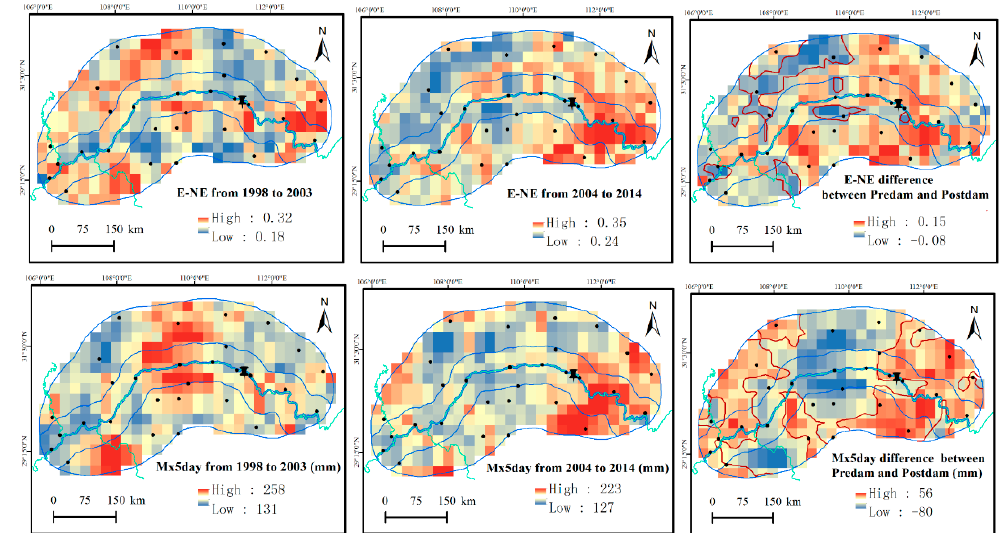
Figure 12. Spatial distribution of mean P95 , E–NE , Mx5 from TRMM data for pre-dam and post-dam period, their difference between pre-dam and post-dam period.